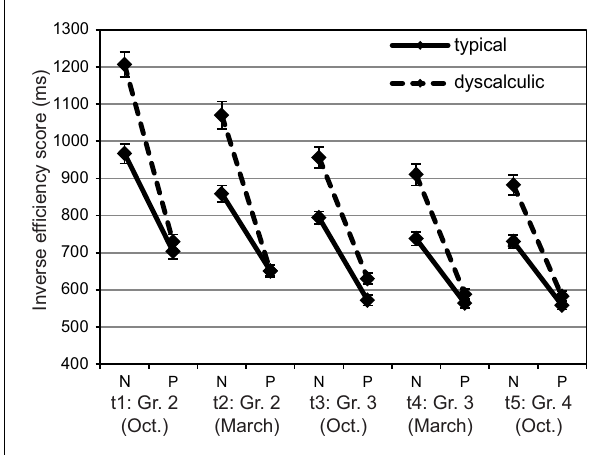
FIGURE 2 | Efficiency of numerical processing: Mean IE-scores (SEs as error bars) for numerical (N) and physical (P) comparison across five assessment